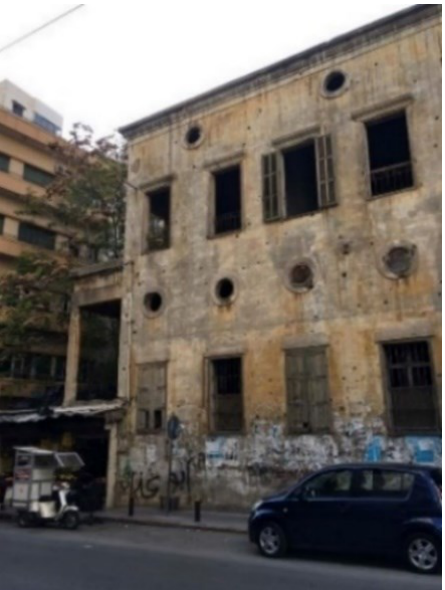
Figure 4. Photo of an abandoned traditional two-storey building in Ras el Nabeh region, Beirut (photo available at Beirut Heritage group, archived in 2017)